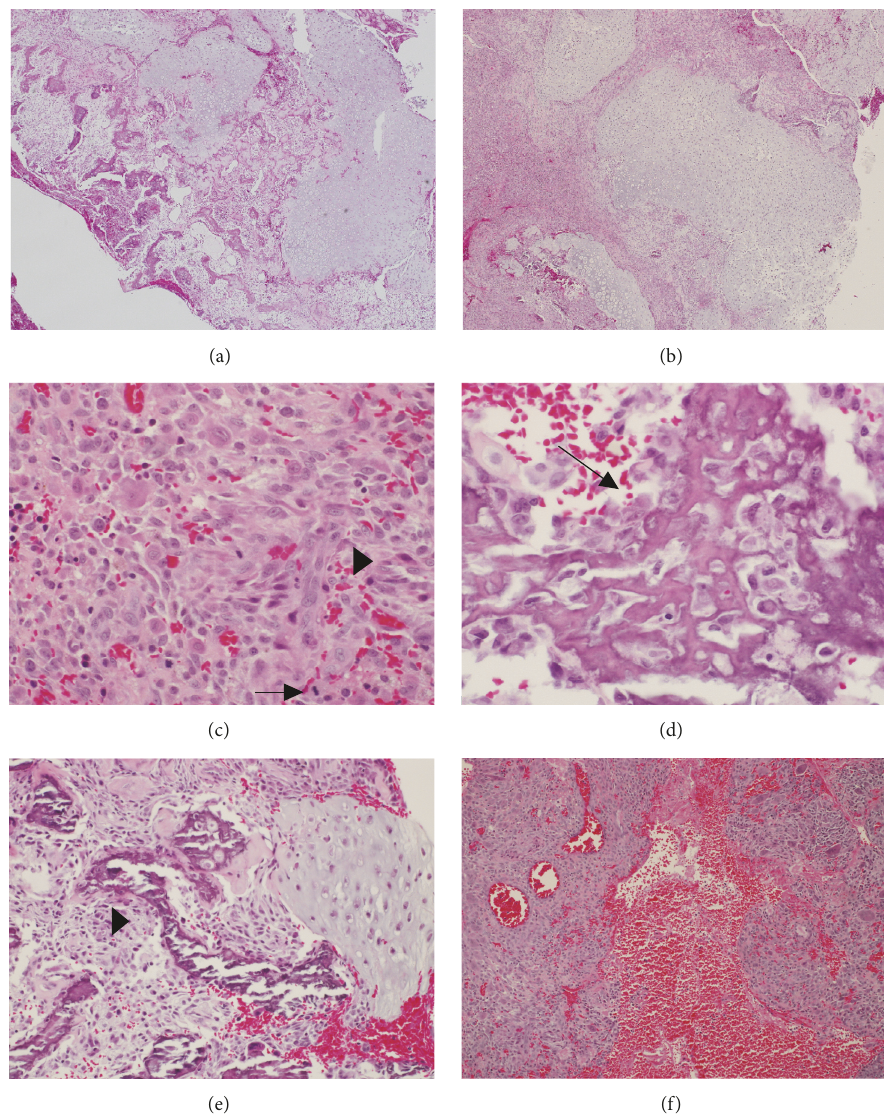
Figure 2: Microscopic findings: (a + b) islands of hypercellular cartilage interspersed within mesenchymal-like stroma of spindle cells. (c) Magnified image of the mesenchymal stroma showing mild atypia (arrow head) and mitosis (arrow). (d + e) Magnified image showing focal endochondral ossification (arrow head) and bone trabeculae (arrow). (f) Area of aneurysmal bone cyst formed of hemorrhagic dilated cystic spaces lined by osteoclasts, giant cells, and collagenous